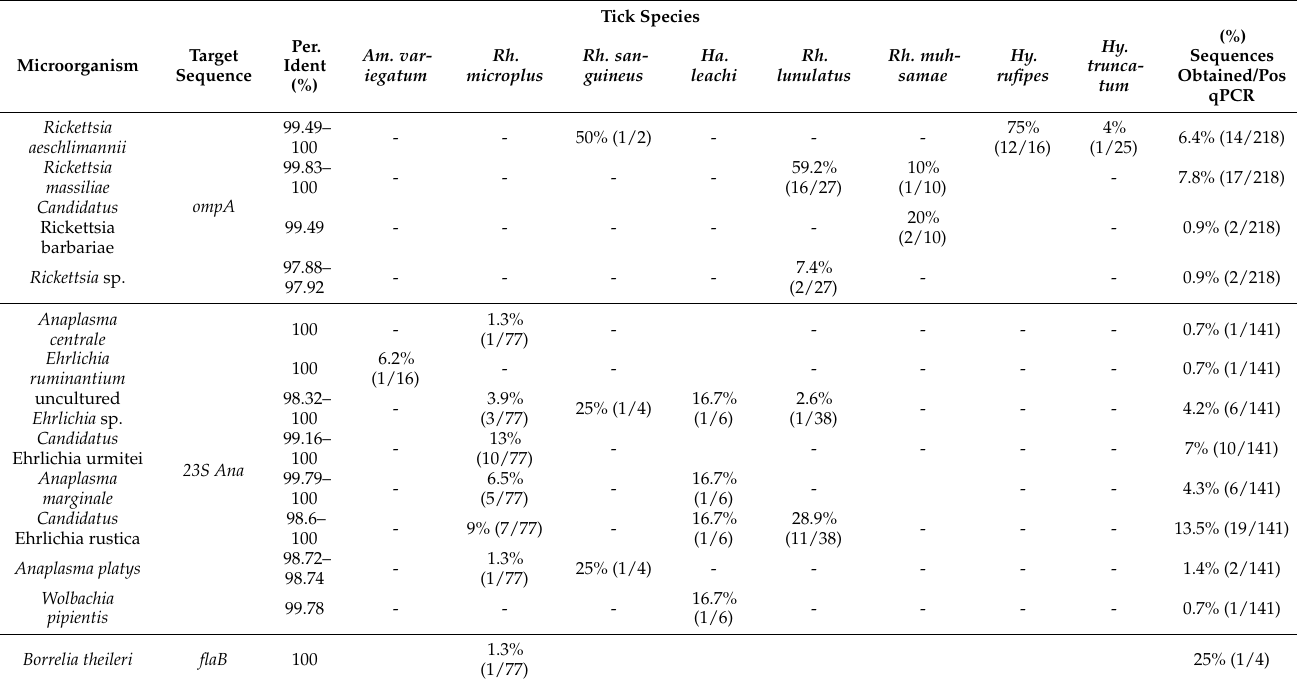
Table 4. Tick species collected in Cameroon and studied for